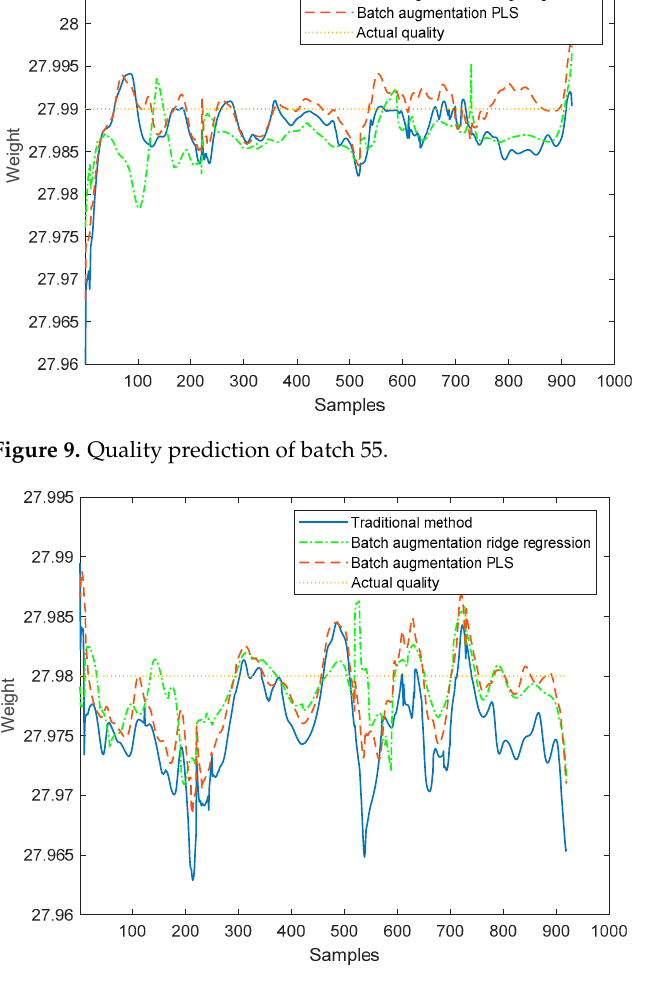
Figure 10. Quality prediction of batch 60.